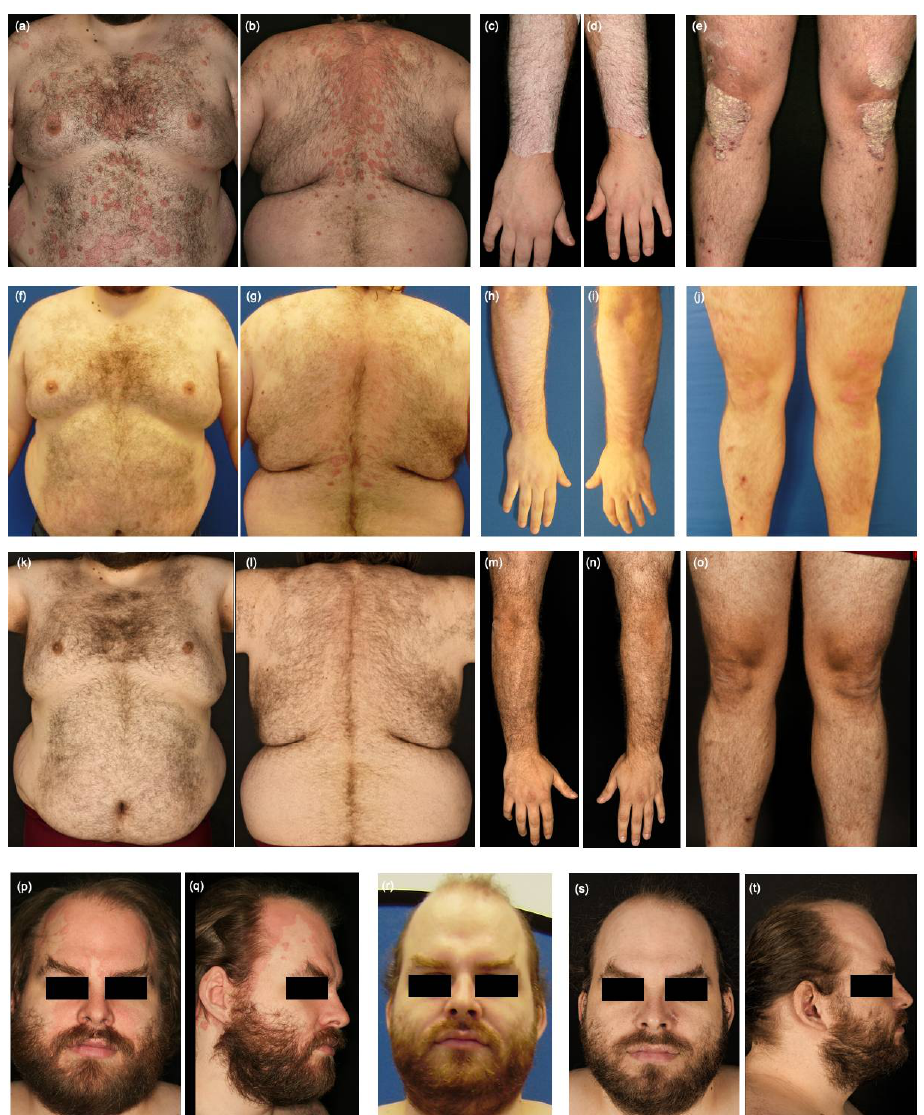
Figure 2. Psoriasis plaques on the trunk ( a , b ) and the upper and lower extremities, predominantly on dorsal forearms ( c – e ) marked by confluent red, well-demarcated, scaly plaques under risankizumab for two years (PASI 19.5; DLQI 21). Improvement of psoriasis of the trunk and the extremities 4 weeks ( f – j ) (PASI 3.7; DLQI 7) and 12 months ( k – o ) (PASI 0; DLQI 0) after the first injection of bimekizumab 320 mg. Resolution of scalp psoriasis after 4 weeks ( r ) and 12 months ( s , t ) of therapy compared to baseline ( p , q ).